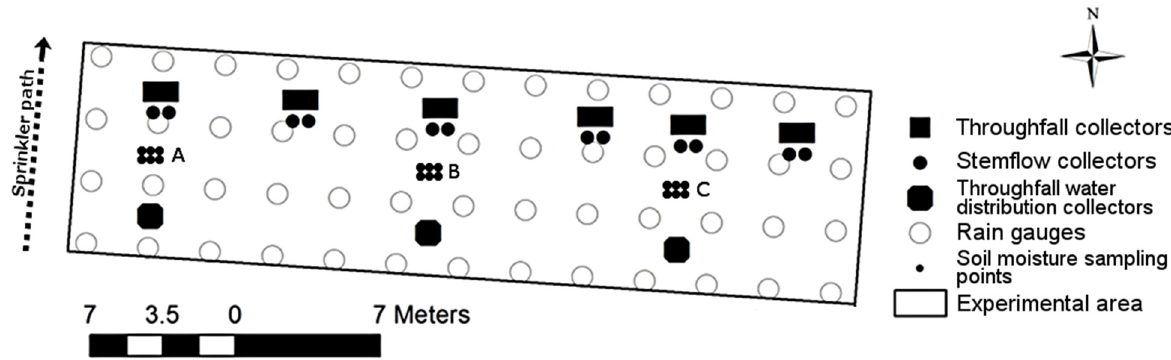
Figure 2. Plot setup with the relative position of throughfall and stemflow collectors, rain gauges and soil moisture sampling